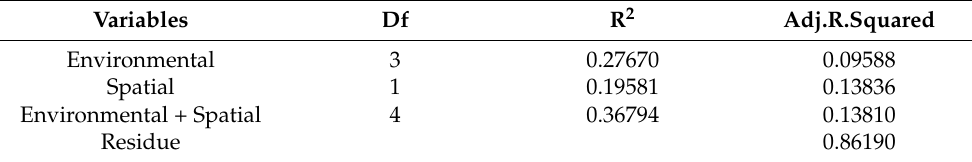
Table 3. Partition of the RDA for environmental and spatial variables related to